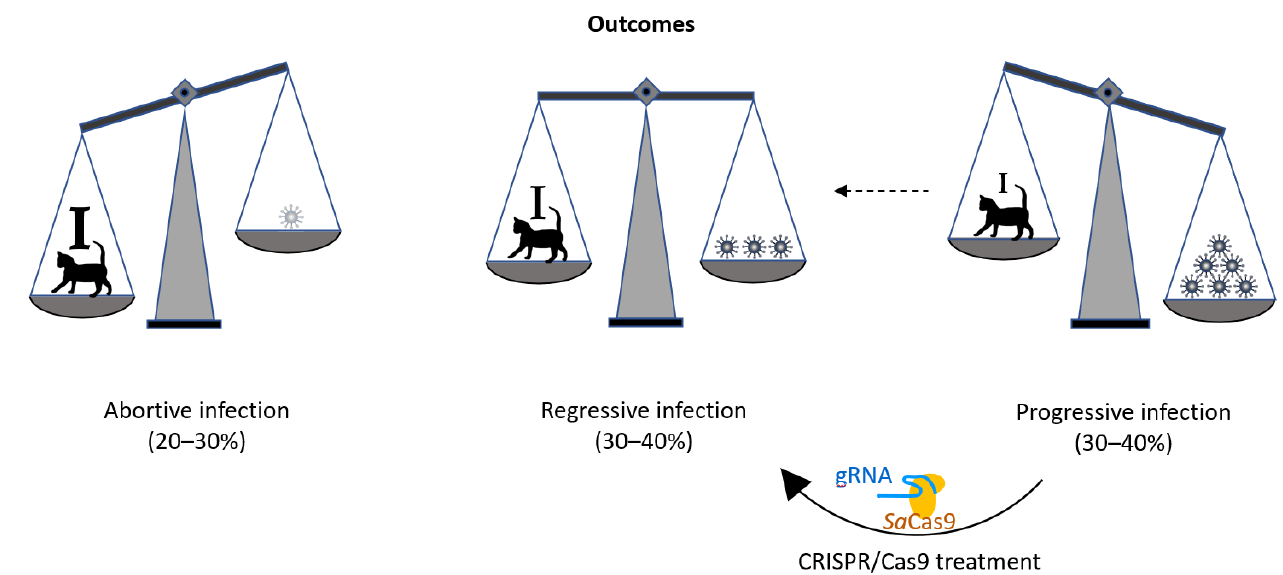
Figure 1. Schematic drawing of the outcomes of FeLV. In the course of FeLV infection, the virus/provirus load often corresponds to the disease outcome. Whereas during an abortive infection the cat’s immune response successfully eliminates viral proliferation (strong immune system: I ), during progressive infection viral loads are constantly high (lack of effective FeLV-specific humoral and cellular immunity: I ). During regressive infection, an effective immune response (marked with I ) can control FeLV, often during the entire lifetime of the cat, thereby omitting FeLV-related disease and death. It is the goal of this study to develop the tools to shift the outcome of FeLV infection from progressive to regressive, with the help of a CRISPR/ Sa Cas9 treatment that reduces the FeLV proviral loads in the cats’ cells and helps the immune system to overcome viremia.